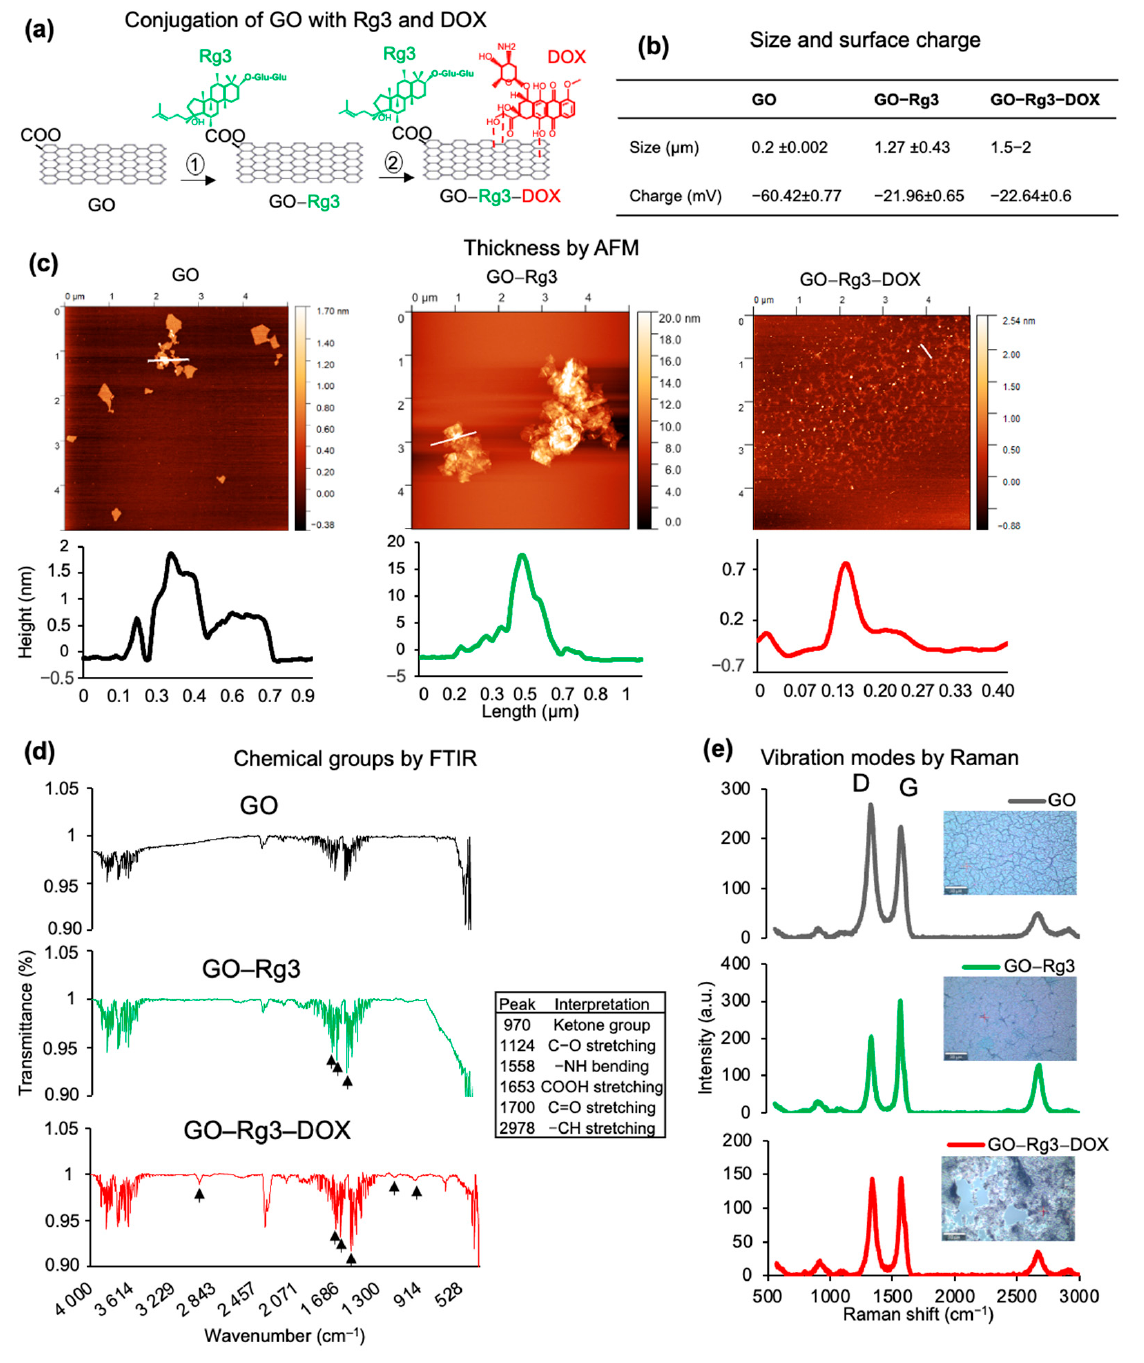
Figure 1. Physical and chemical characterization of GO, GO–Rg3, and GO–Rg3–DOX. ( a ) Schematic depiction of conjugation of GO with Rg3 and DOX. The dotted lines indicate non-covalent binding of DOX to GO. ( b ) Size and surface charge of GO, GO–Rg3, and GO–Rg3–DOX. ( c ) Representative AFM images of GO, GO–Rg3, and GO–Rg3–DOX. Height profile of white lines is shown below each AFM image. ( d ) FTIR analysis of GO, GO–Rg3, and GO–Rg3–DOX. The respective peaks shown by black arrows are listed in the table. ( e ) Raman spectra (left) and bright filed images (right) of GO, GO–Rg3, and GO–Rg3–DOX taken by Raman microscopy.